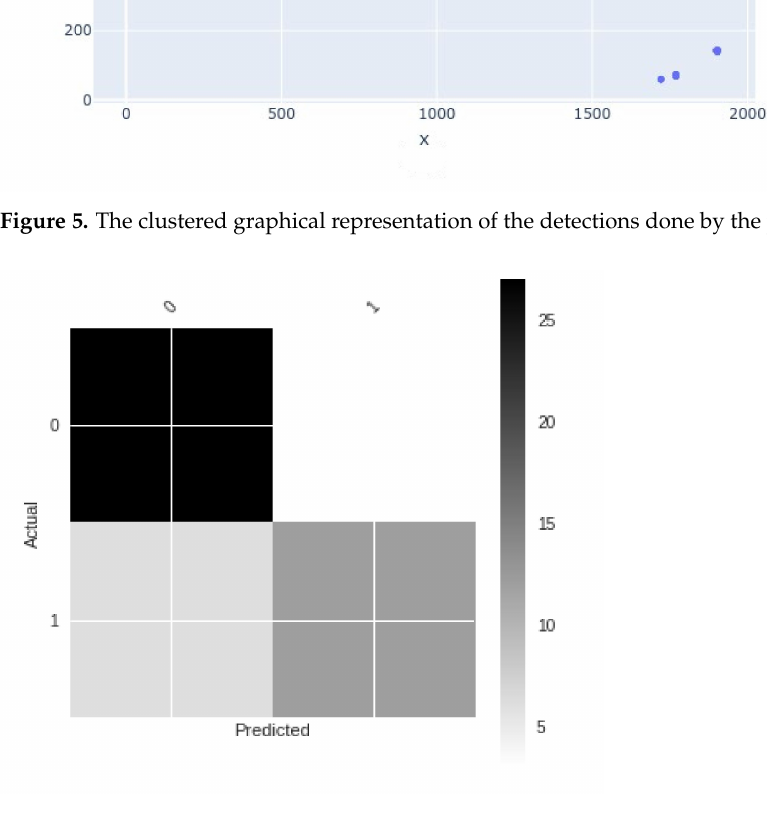
Figure 6. The plotted confusion matrix for detections done by the framework. Table 2. Confusion matrix for detections done by the